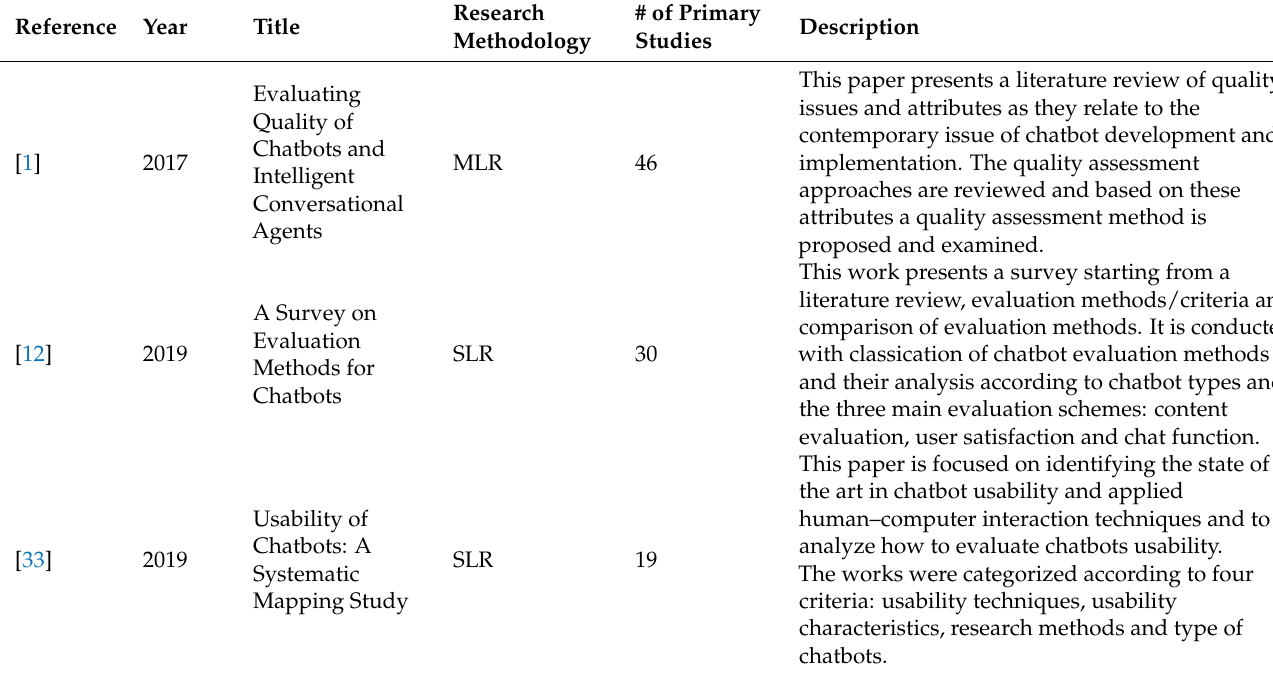
Table 1. Secondary